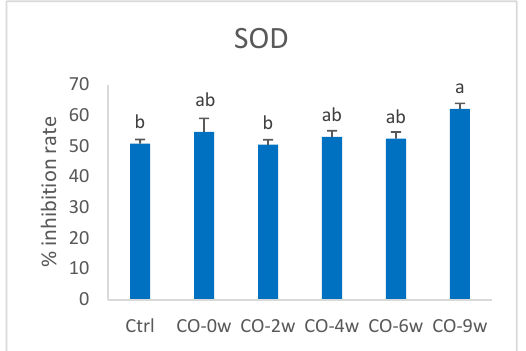
Figure 4. Activity of SOD (% inhibition rate) in HT29 cells exposed to oxidized camelina oil. All groups, except the control group (Ctrl), were cultured in growth media containing 0.5 mg/mL oxidized camelina oil for 72 h. Data (n = 4) are means shown with standard error mean. Significant differences are indicated with different letters evaluated with Tukey–HSD ( p < 0.05). CO = camelina oil; w = weeks.